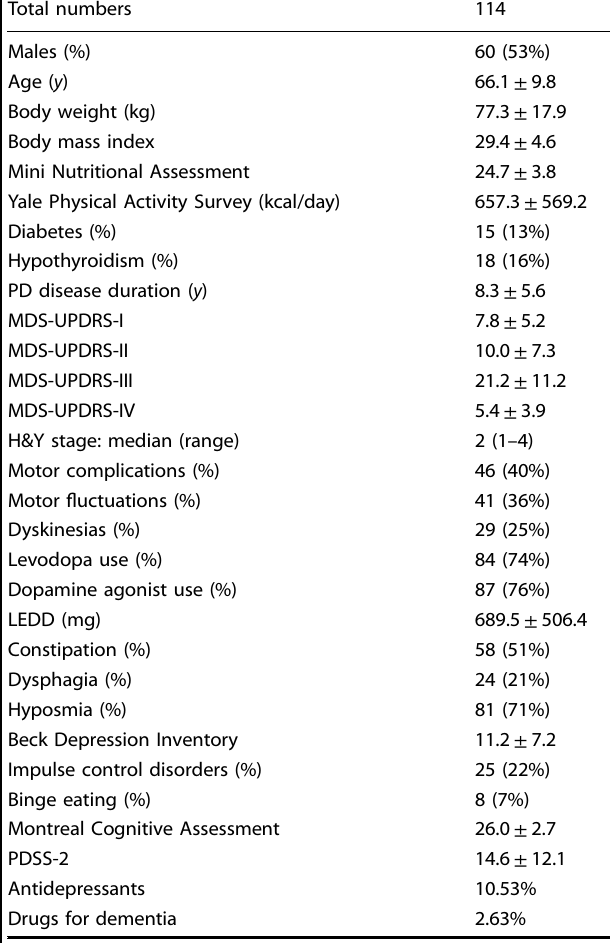
Table 1. Demographic and clinical features of PD patients Total